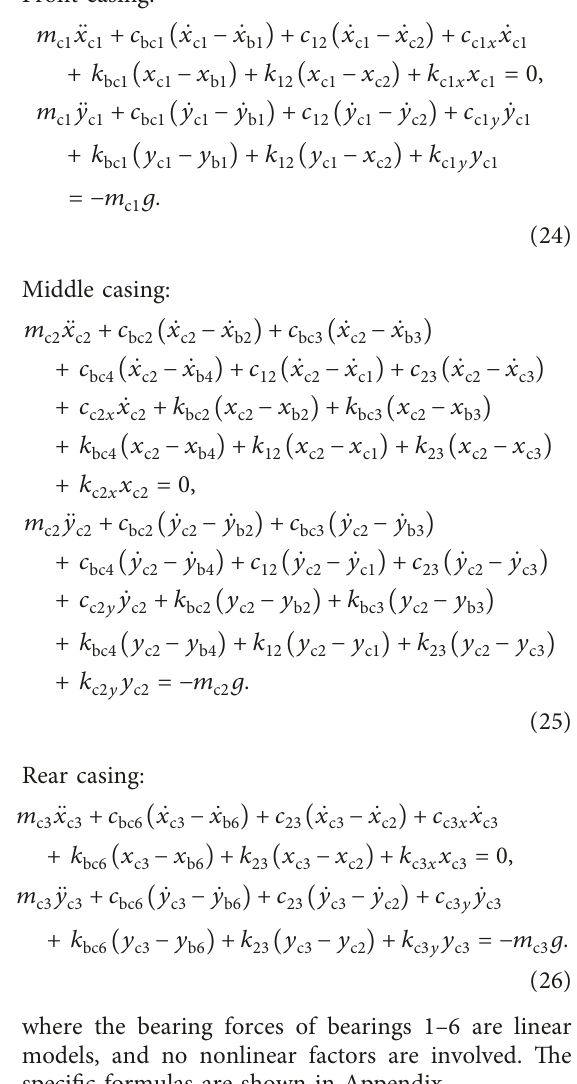
Table 1: Main parameters of the dual-rotor-casing